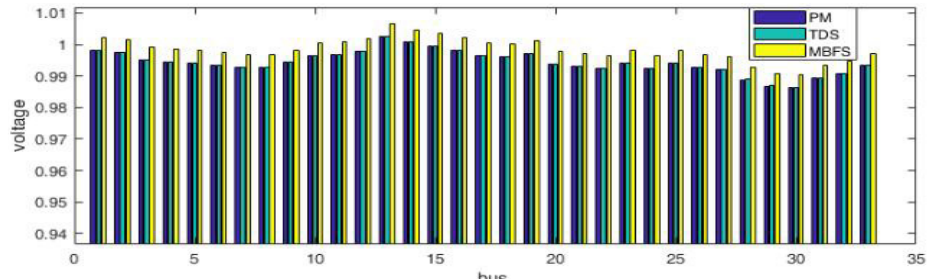
Figure 6. Voltage results for conventional droop control.